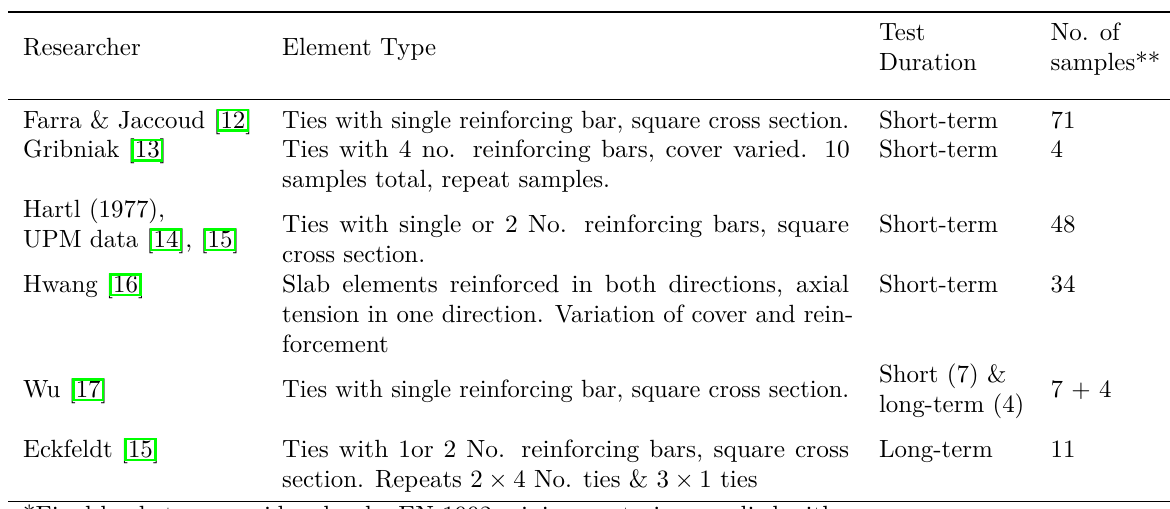
Table 1. Sources of experimental data - direct tension load-induced